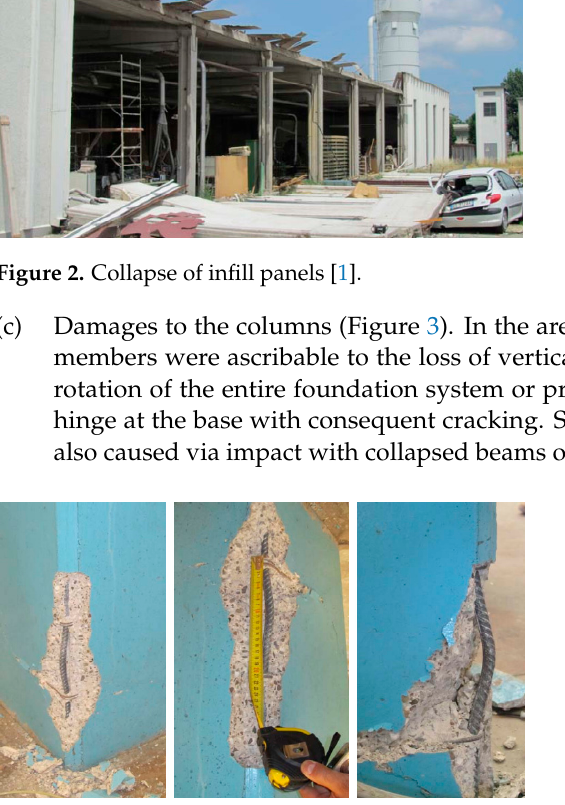
Figure 3. Damage to columns [1].